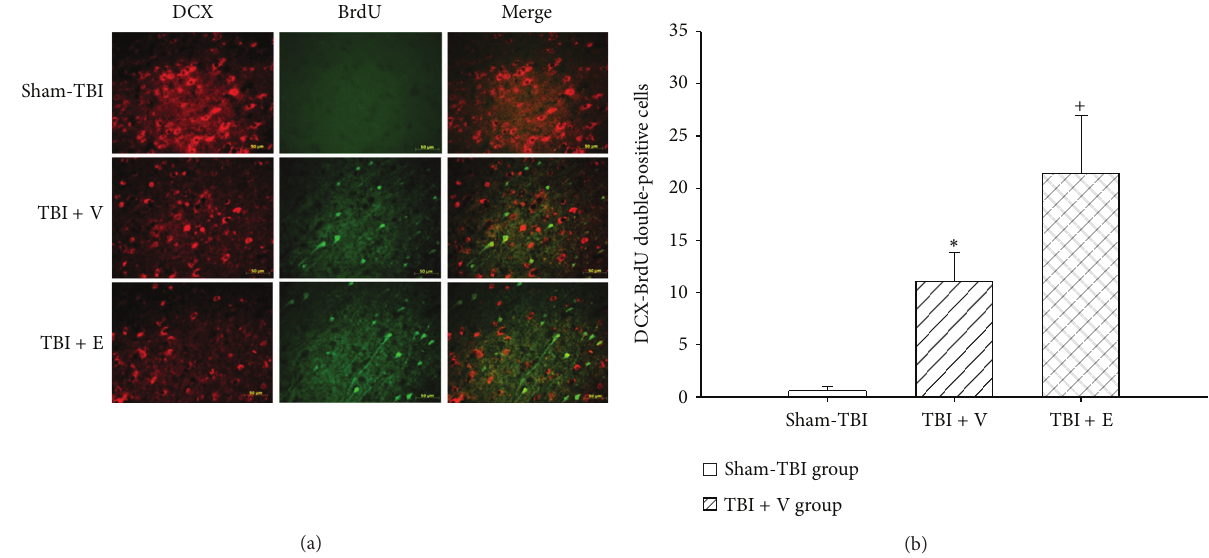
Figure 4: Mean ± standard deviation values of the number of BrdU-DCX-positive cells in the penumbra ischemic cortex (see the legend of Figure 1 for group abbreviations). The data were obtained 7 days after TBI or sham-TBI operation ( 𝑛 = 8 ). ∗ 𝑃 < 0.05 compared with the sham-TBI group (white column); + 𝑃 < 0.05 compared with the TBI + V group (lined column). Right panels depict representative DCX-BrdU double stainings for one sham-TBI rat, one TBI + V rat, and one TBI + E rat.